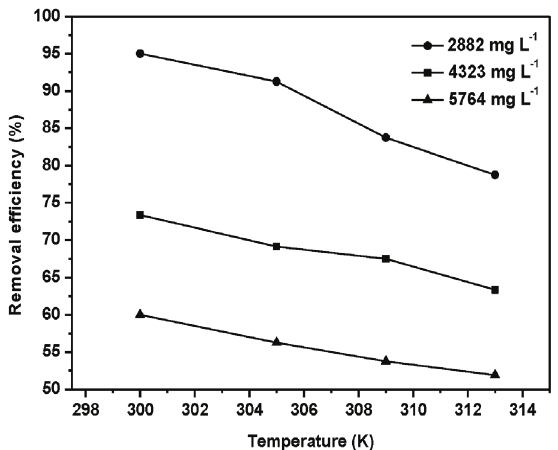
Fig. 7 – Effect of temperature on the removal efficiency of acrylic acid onto CaO nanoparticles (initial acrylic acid concen- 2 tration = 2882, 4323, 5764 mg L –1 , adsorbent dosage = 1 g L –1 , time = 125 min, temperature = 300.15 – 313.15